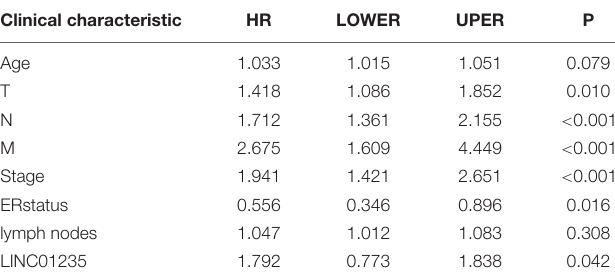
TABLE 7 | Univariate analysis of LINC01235 in breast cancer patients. Clinical characteristic